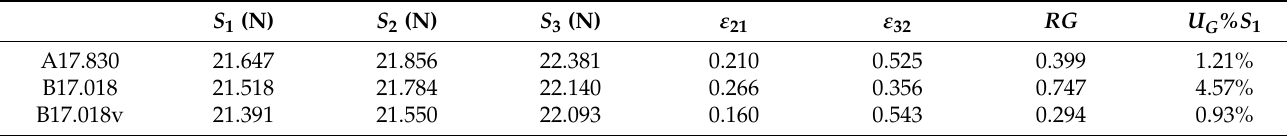
Table 6. Verification result for the optimal